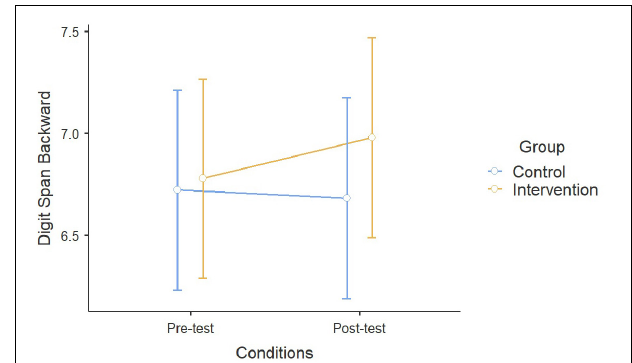
FIGURE 3 | Results on the Digit Span Backward.